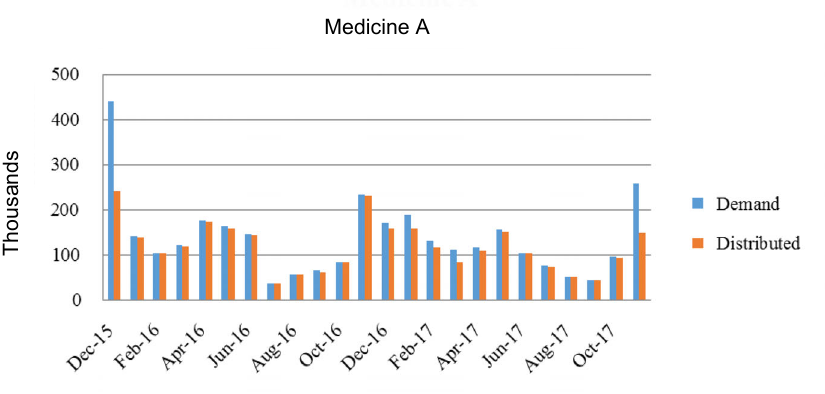
Fig. 1. Medicine A demand behaviour.